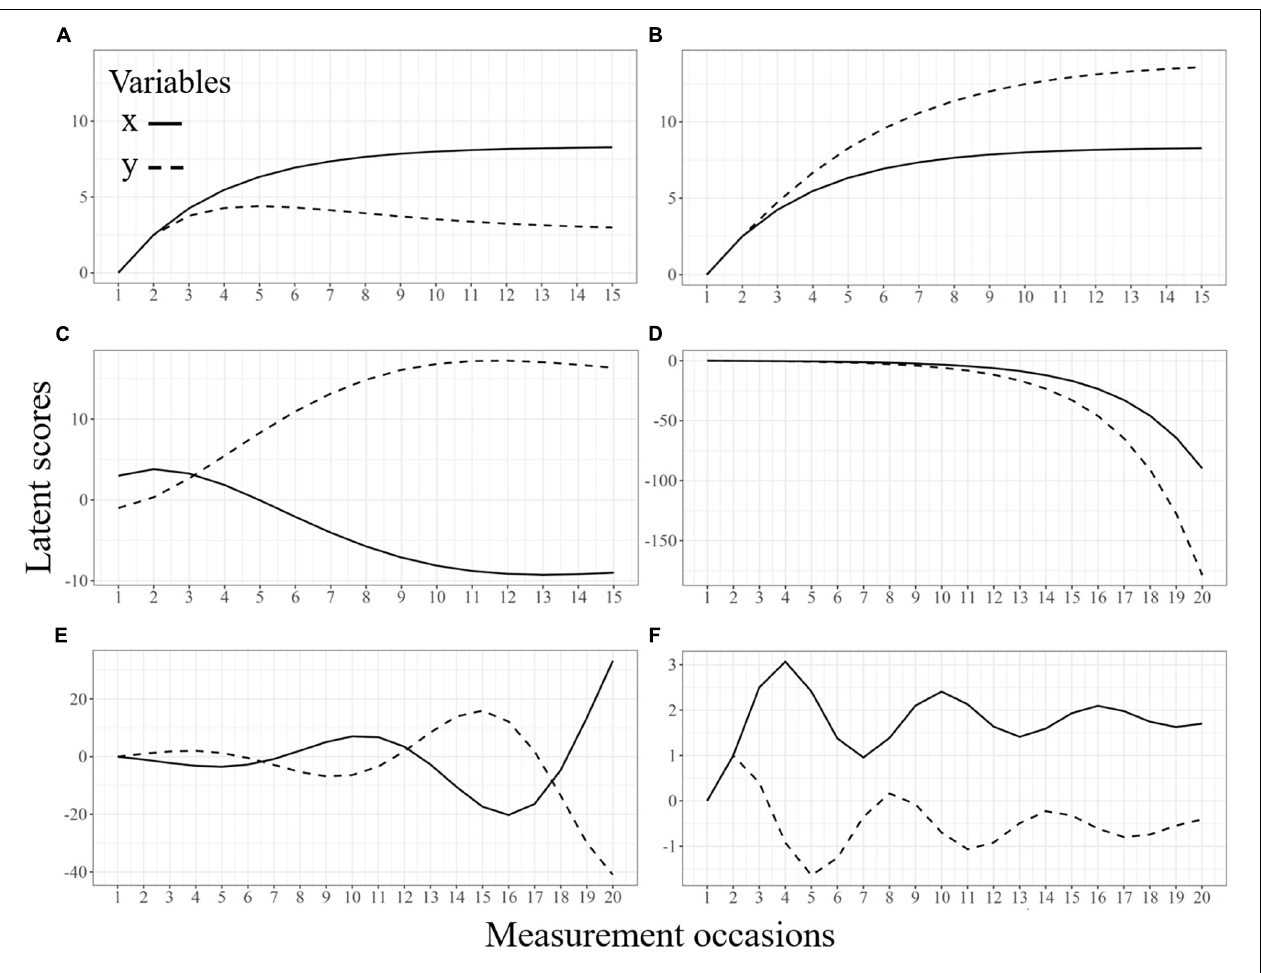
FIGURE 6 | (A–F) Implied mean trajectories from a bivariate LCS model under various parameter values.